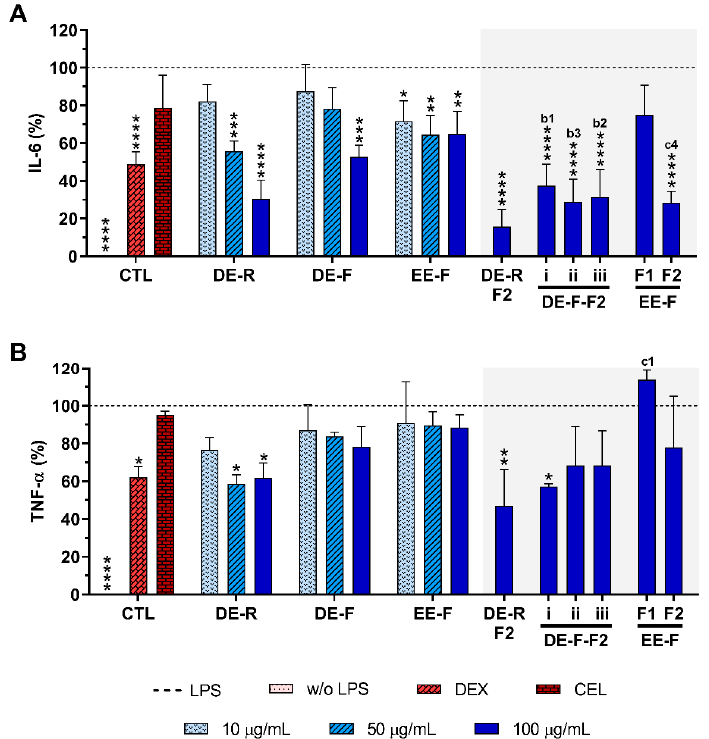
Figure 5. IL-6 ( A ) and TNF- α ( B ) production by LPS-stimulated human monocyte-derived macrophages (hMDMs) cultured in the presence of different concentrations of the E. purpurea extracts, fractions, and clinically used anti-inflammatory drugs (dexamethasone (DEX) and celecoxib (CEL), 10 µ M) for 24 h. Statistically significant differences are * ( p < 0.0363), ** ( p < 0.0047), *** ( p < 0.0003), and **** ( p < 0.0001) in comparison to the positive control (LPS-stimulated hMDM without treat- ment) for all tested E. purpurea extracts, fractions, DEX, and CEL and 1 ( p < 0.0428), 2 ( p < 0.0018), 3 ( p < 0.0003), and 4 ( p < 0.0001) in comparison with b (DE-F vs. DE-R-F2) and c (EE-F vs. EE-F-F) at the same concentration. CTL: control; DE: dichloromethanolic extracts; EE: ethanolic extracts; R: roots; F: flowers; F1: phenol/carboxylic acid fraction; F2: alkylamide fraction.